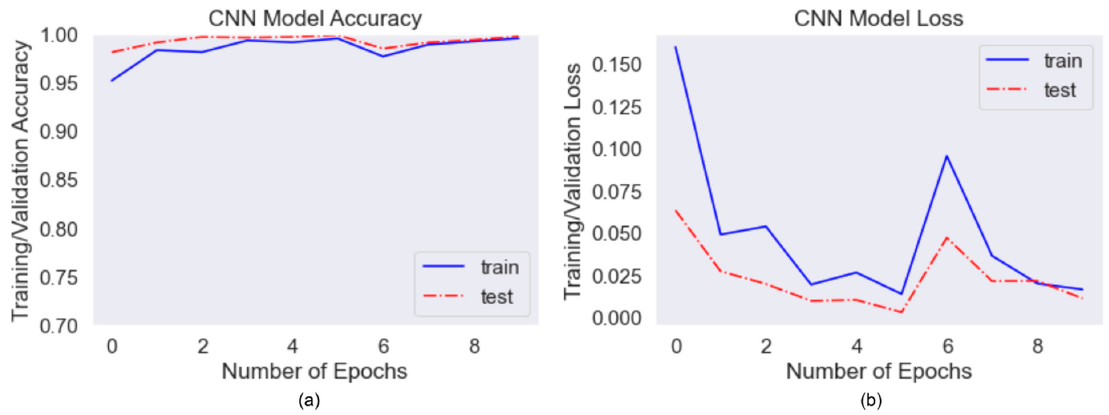
Figure 9. ( a ) CNN Accuracy Curve, ( b ) CNN Loss Curve.